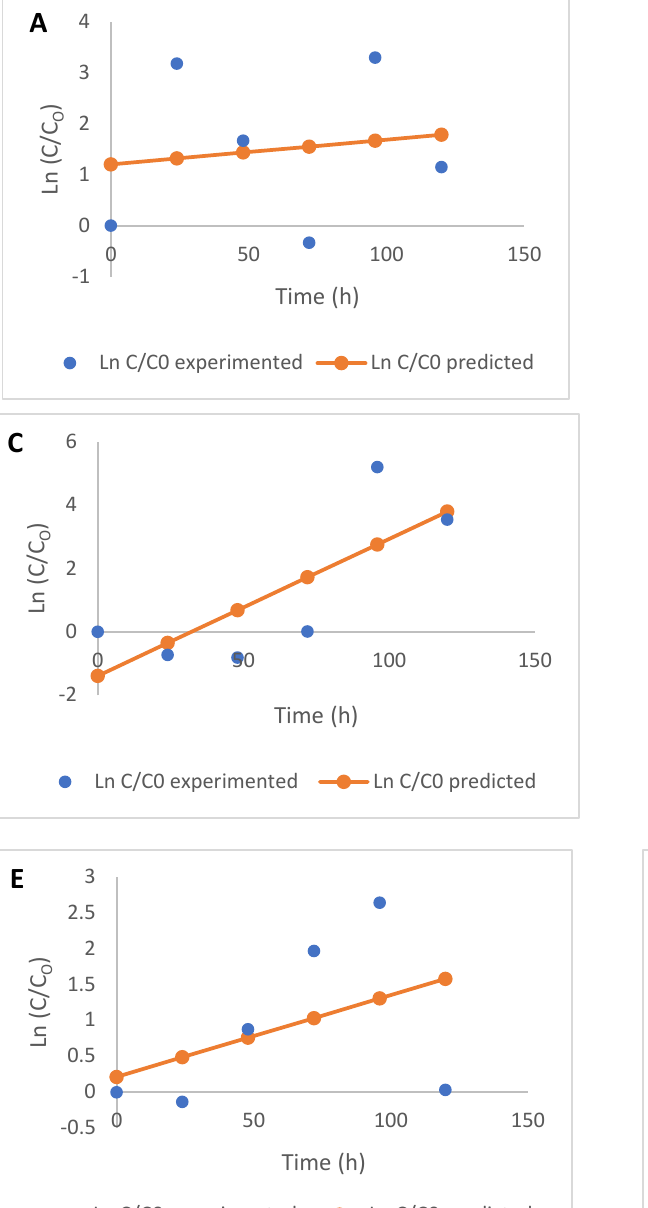
Figure 5. Kinetics (second-order) of free phenolic acid degradation during the fermentation of maize flour ( A ) caffeic acid, ( B ) ferulic acid, ( C ) gallic acid, ( D ) p -coumaric acid, ( E ) sinapic acid, and ( F ) vanillic acid.